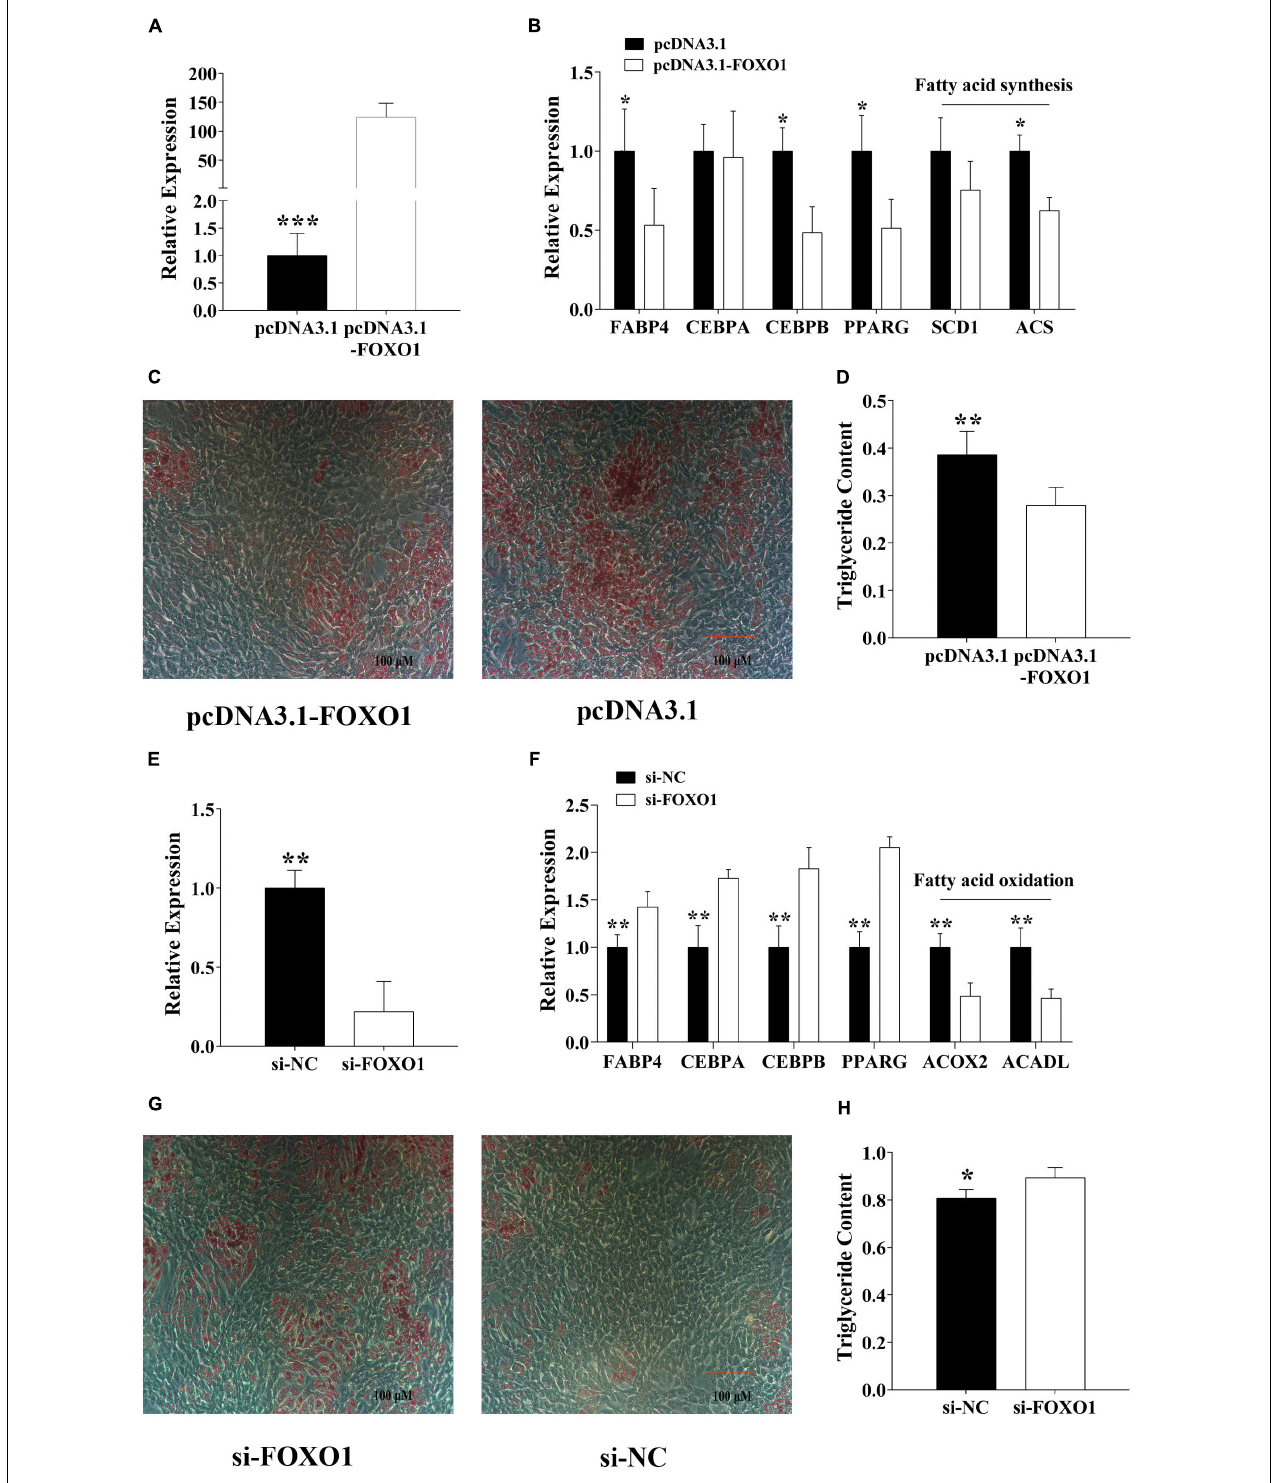
FIGURE 3 | FoxO1 suppresses pre-adipocyte differentiation. (A) Overexpressed FoxO1 in pre-adipocytes. (B) Detected adipogenic label genes in pre-adipocytes after FoxO1 overexpression. (C,D) After 8-day differentiation inducer medium (DIM) stimulation, oil red O staining (C) , and triglyceride assay (D) . (E) Specific interference of FoxO1 by siRNA in pre-adipocytes. (F) After interference of FoxO1, the expression level of adipogenesis label genes in pre-adipocytes was detected. (G,H) After 8-day differentiation inducer medium (DIM) stimulation, oil red O staining (G) , and triglyceride assay (H) . * p < 0.05, ** p < 0.01, and *** p < 0.001.